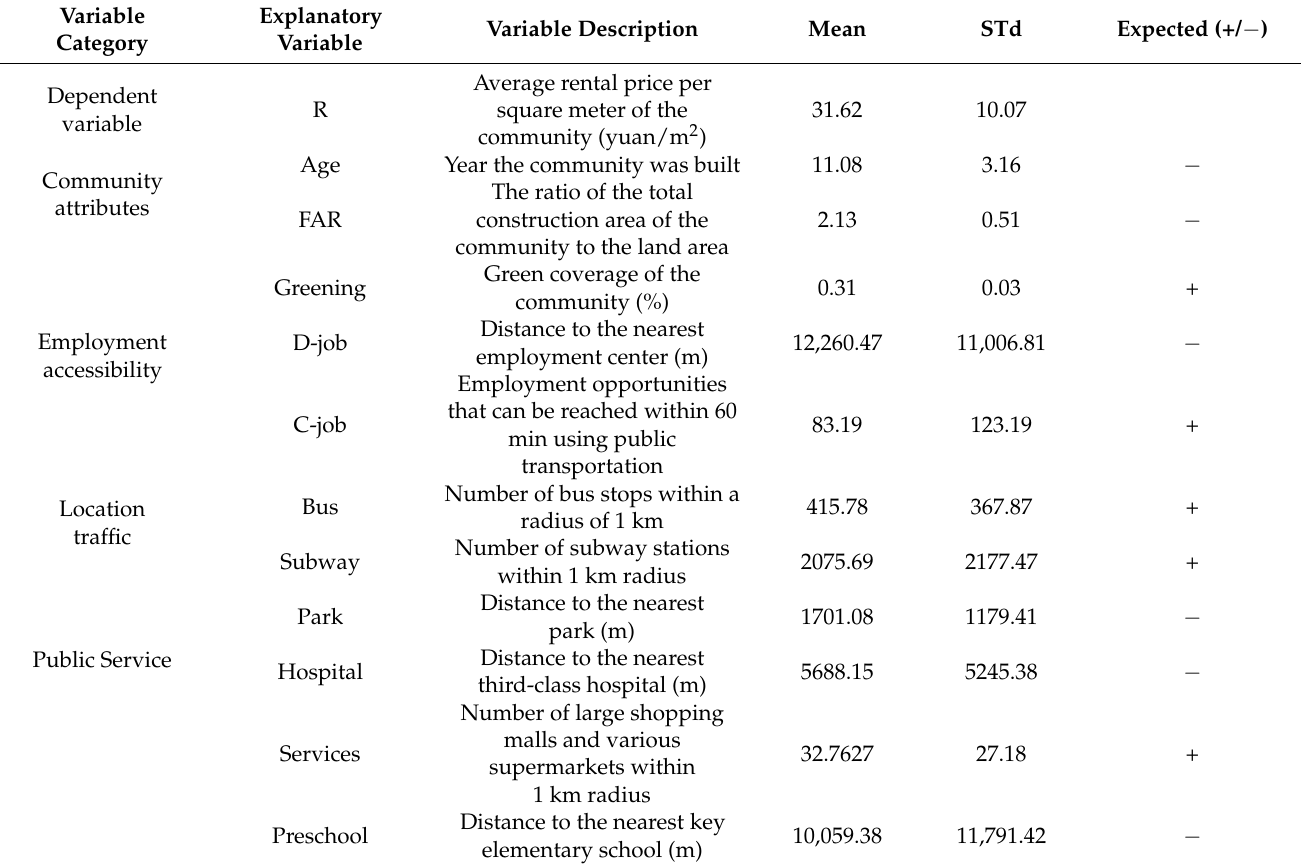
Table 1. Statistics for Variable